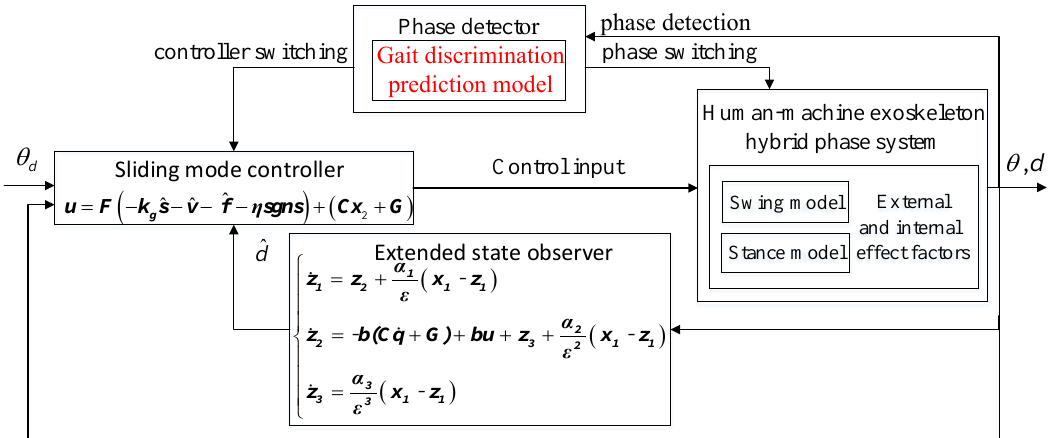
Figure 1. Control strategy block diagram for the exoskeleton in hybrid